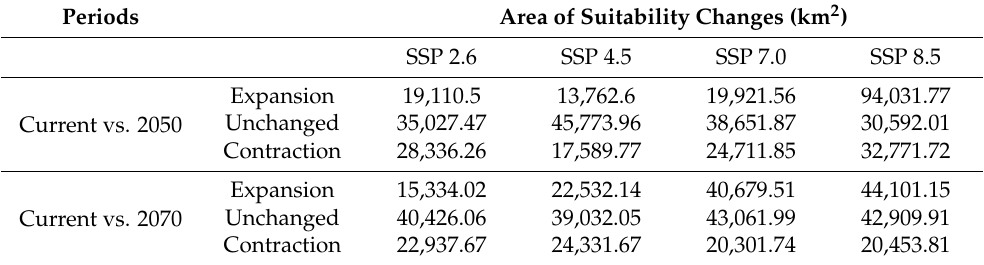
Table 2. Habitat suitability changes from the current conditions to the future climate (2050s